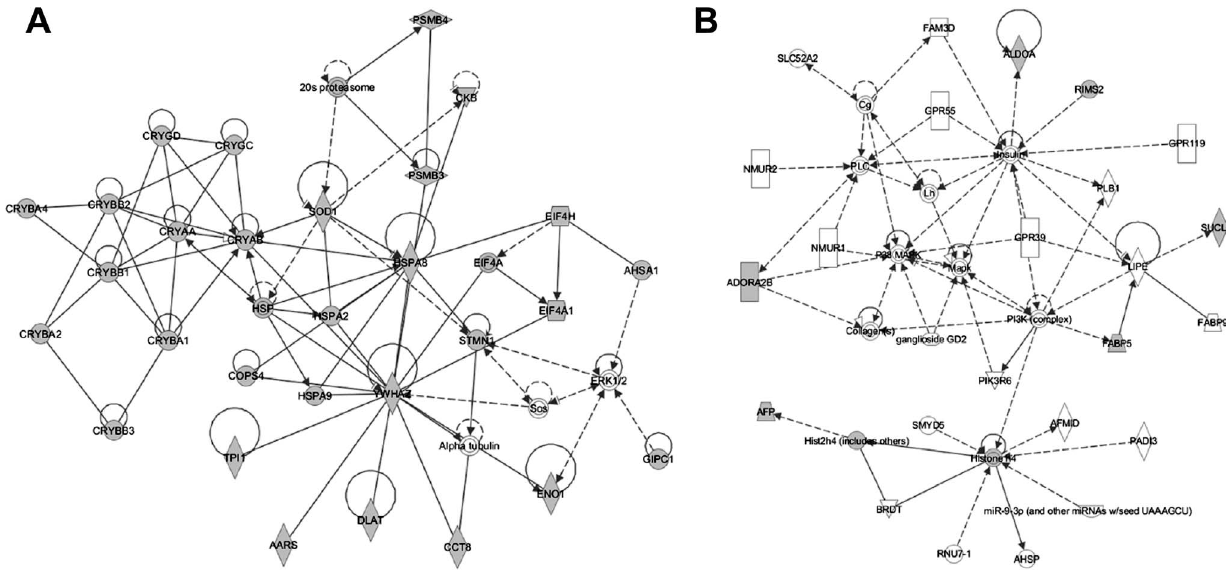
Figure 8. Ingenuity Pathways analysis of lens proteins identified in a A-R49C knock-in mutant lenses. Analysis of altered protein networks by Ingenuity Pathway software. Biological networks and pathways generated from input data (Wild-type vs. a A-R49C, Tables 1-3 and Table S1) indicate proteins with altered abundance in gray. (A) A network with HSPA8 at the hub. (B) A second network highlights Histone H4 at the hub of the protein connectivity map. Additional networks are shown in Fig. S3 in File S1.